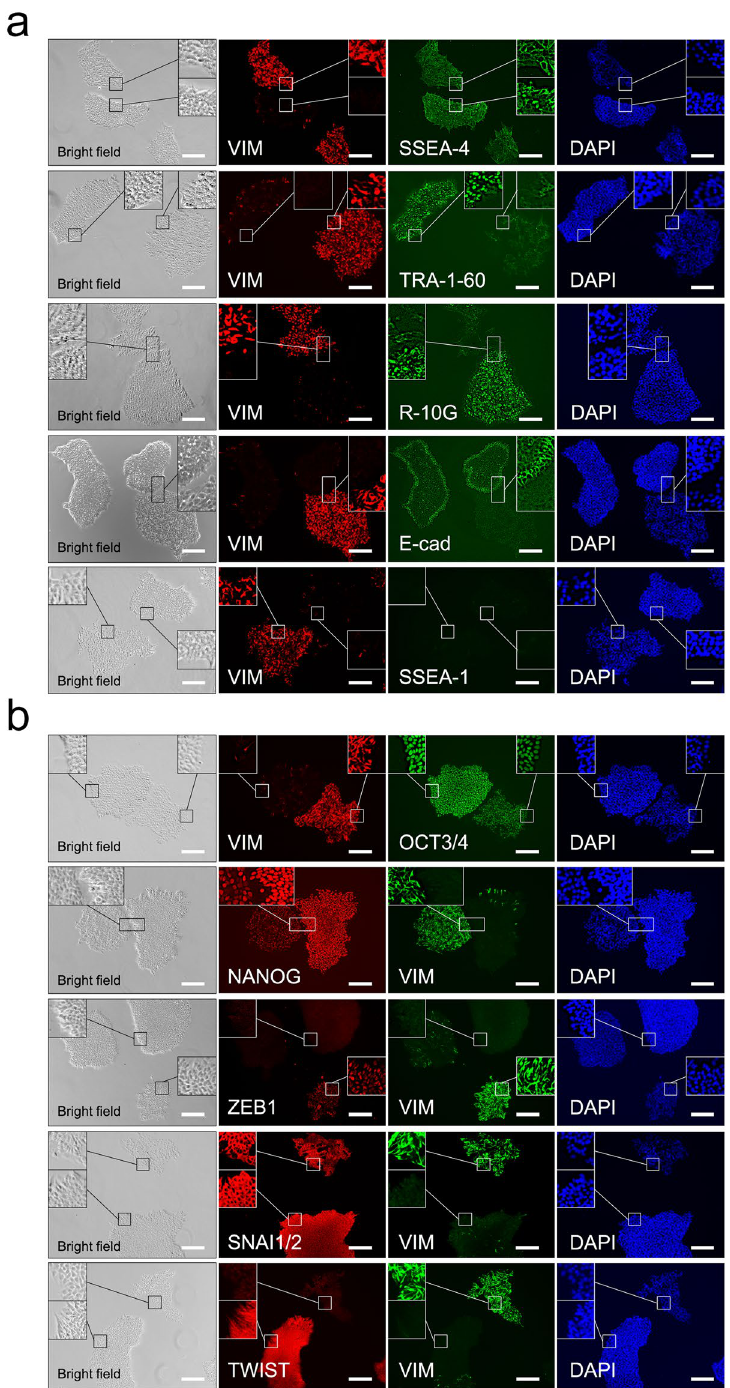
Figure 3. Immunohistochemical analysis of pluripotency, differentiation, and epithelial-to-mesenchymal transition markers in H9 cells cultured on Matrigel. ( a ) Immunohistochemistry with no permeabilisation using antibodies for vimentin (VIM), SSEA-4, TRA-1-60, R-10G, E-cadherin (E-cad), and SSEA-1. ( b ) Immunohistochemistry with permeabilisation using antibodies for VIM, OCT3/4, NANOG, ZEB1, SNAI1/2, and TWIST. Nuclei were counterstained with DAPI. The inset shows a 3 × enlargement of the figure. The scale bar represents 200 µ